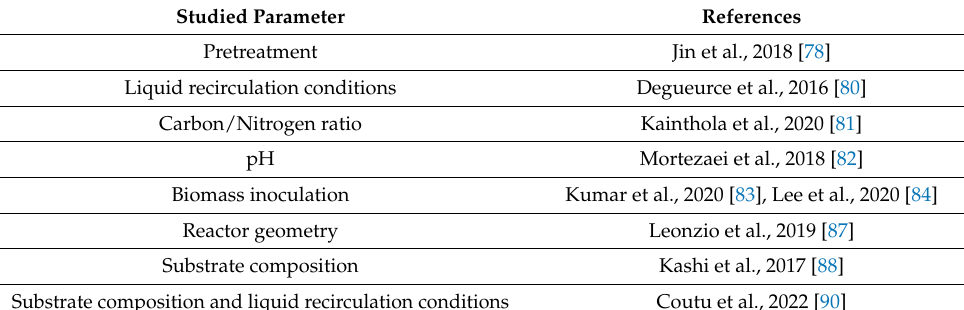
Table 2. Parameters studied for the multiple linear regression models. Studied